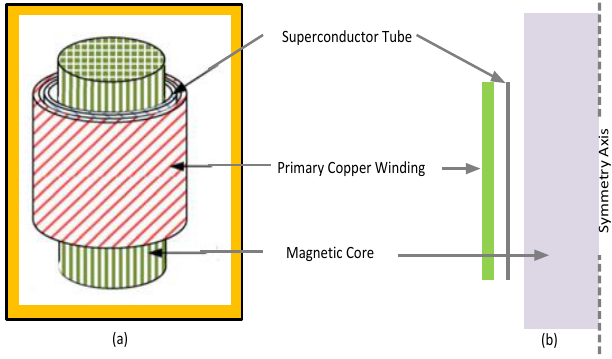
Figure 8. Magnetic Shield SFCL ( a ) Full structural view ( b ) Cross sectional view.